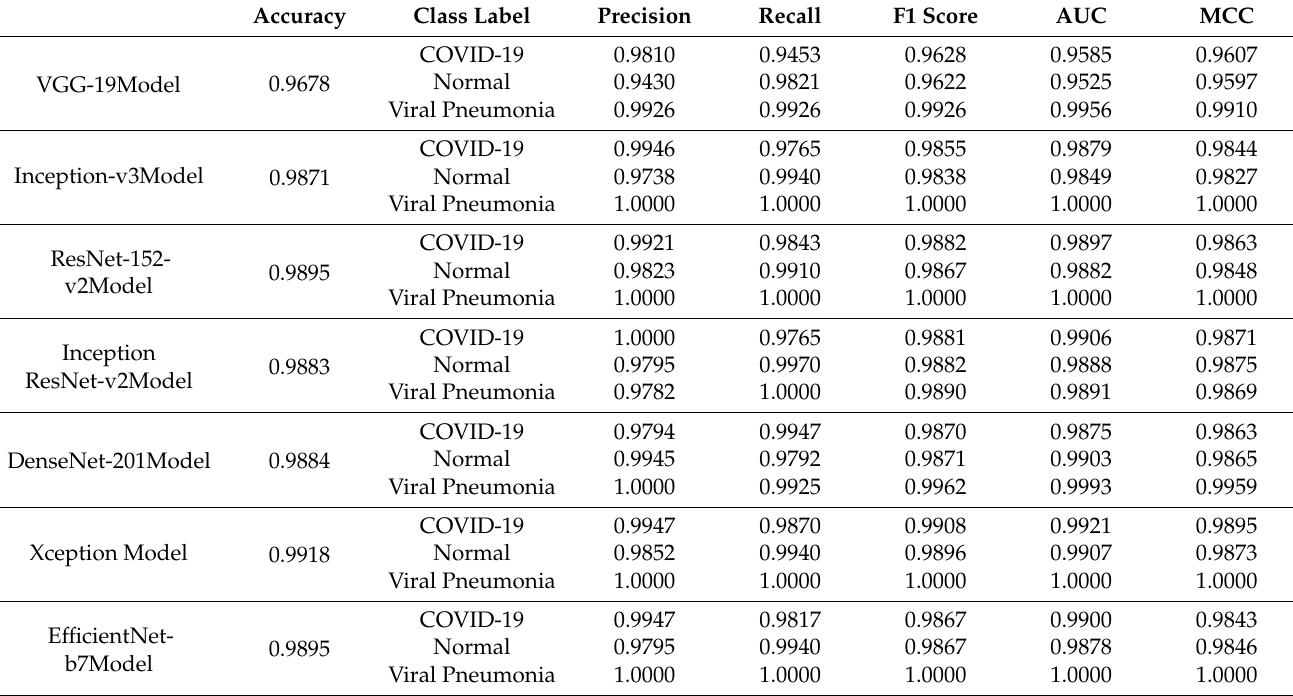
Table 2. Evaluation Metrics for Deep CNN